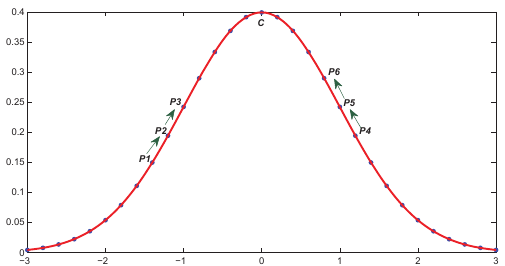
Figure 1: An illustration of the pairwise linkage on a 2D Gaus- sian curve. Derived from the non-maximum suppression, the P- Linkage compares each data point to its neighbors and forms the linkages from p 1 → p 2 → p 3 ... → c .